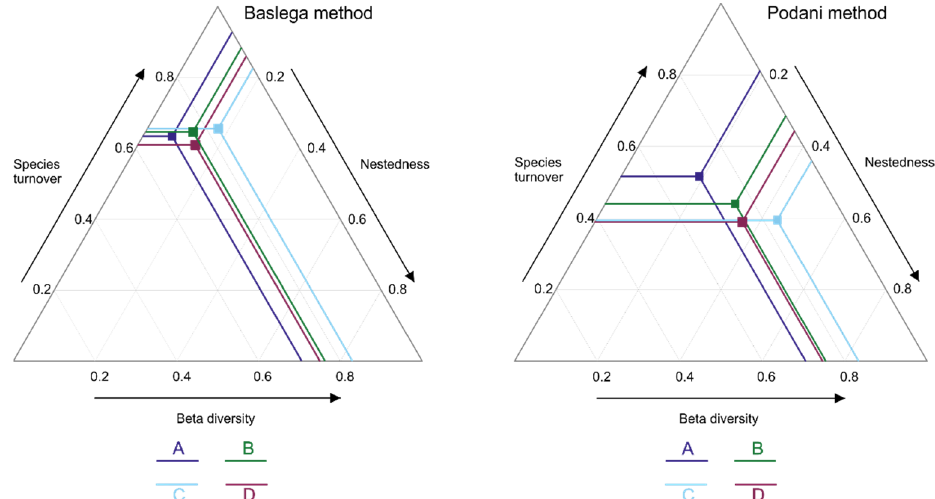
Figure 6. Components of beta diversity in four types of chironomid assemblages (Baselga and Podani methods). Four assemblage types are in capital letters A, B, C, D and coloured as indicated.